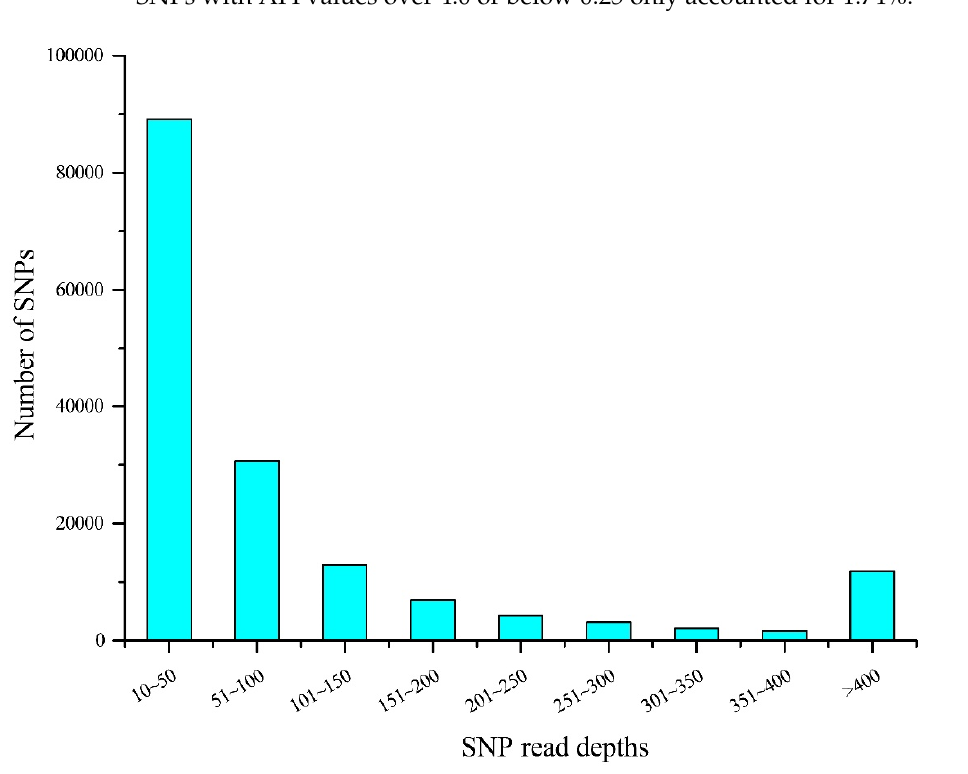
Figure 3. The AFI distribution of 100,633 putative SNPs in linkage groups. 3.5. SNP Annotation and Functional Analysis Of 216,015 hypothetical SNPs, a total of 82,663 SNPs were annotated (Table 5). Among these 82,663 annotated SNPs, most were synonymous SNPs (63,286), followed by 17,790 nonsynonymous SNPs and 1587 unknown SNPs. Here, 133,352 SNPs (61.73%) were not annotated.